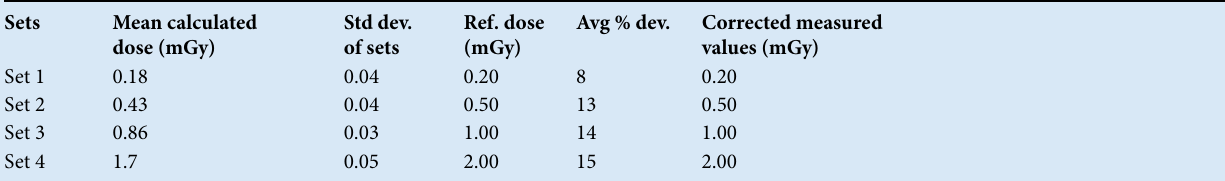
Table II. Results of intercomparison dose measurements of the TLD system